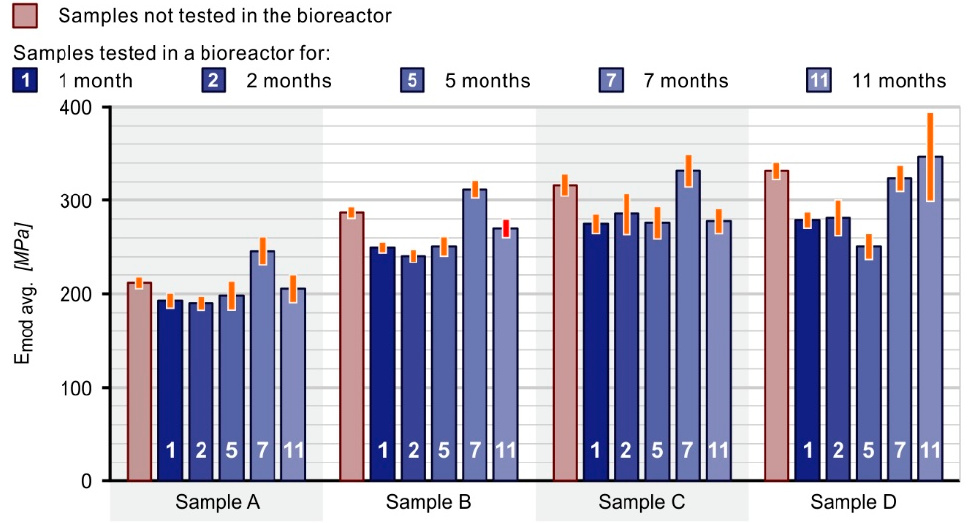
Figure 6. Young’s modulus values of reference and reactor tested paddles.